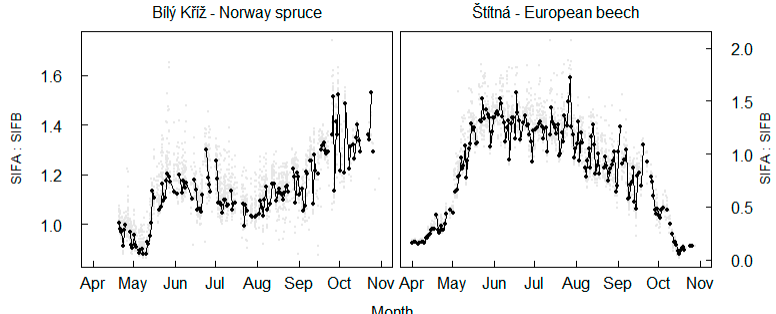
Figure 12. Seasonal variations in the ratio between fluorescence emission in the O 2 A and in the O 2 B band. Black points highlight average seasonal variation in SIFA:SIFB ratio estimated across 2 h long interval in the midday. Grey points show dynamics in 30 min intervals, temporal intervals are equal to those displayed in Figure 5.